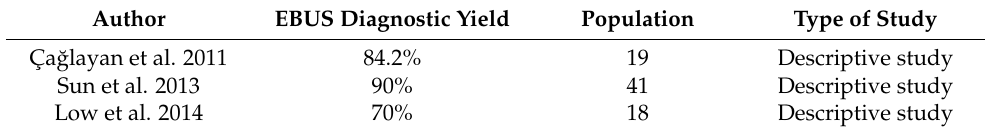
Table 3. A resumptive table of diagnostic yield of EBUS for mycobacterial